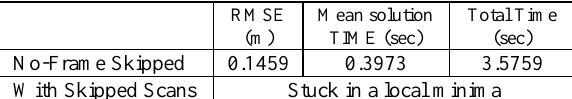
Table 8. Hector SLAM Performance During Second Experiment